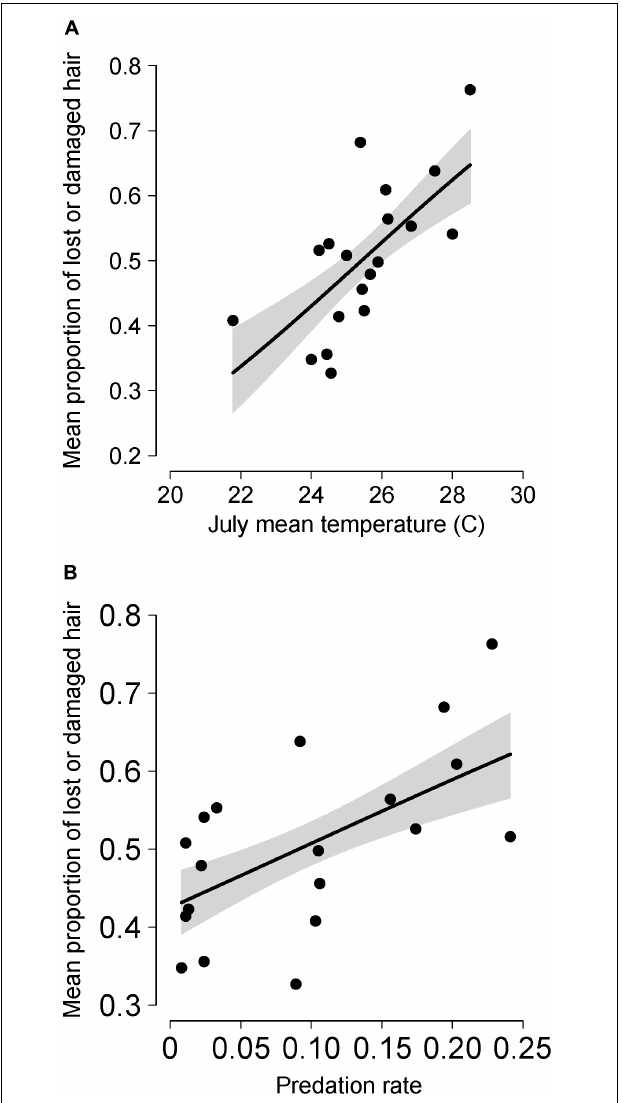
FIGURE 2 | Mean annual values of the proportion of a moose’s neck and torso that had either lost or damaged hair due to winter ticks for moose in Isle Royale National Park over a 19-year period (2001–2019). Mean annual hair loss is shown in relation to the mean daily maximum temperature during July the previous year (A) and annual predation rate (proportion of the moose population killed by wolves) in the same calendar year (B) . Lines depict predictions from the most parsimonious model shown in Table 4 . More specifically, the lines in (A) represent predictions when predation rate was fixed at the median value (0.09) and in (B) when mean maximum temperatures were fixed at the median value (25.44 ◦ C). Gray shaded area indicates the 95% upper and lower confidence intervals around